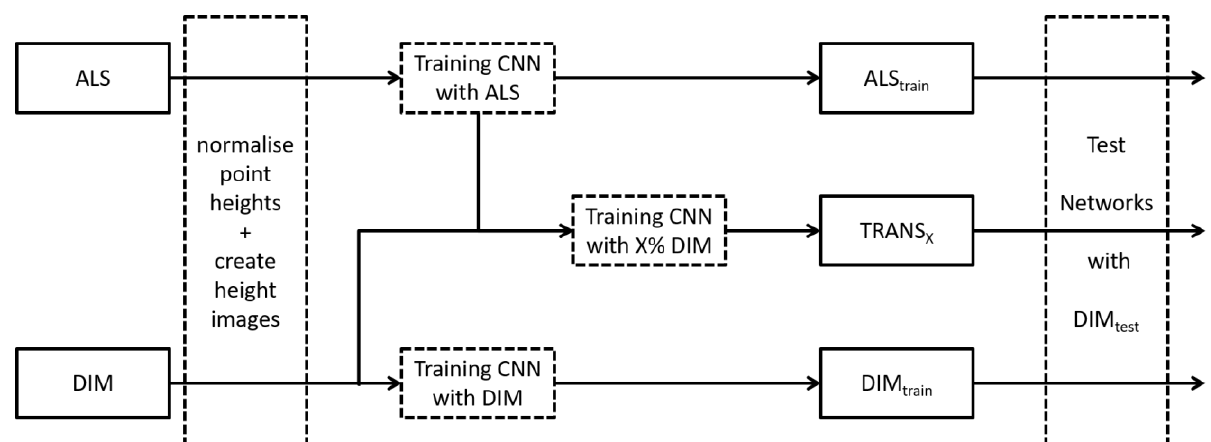
Figure 1: Workflow of our method. The heights of ALS and DIM point clouds are normalised and height images are created. ALS train , and DIM train are trained based exclusively on ALS or DIM point cloud as input data. TRANS x takes ALS train as baseline and fine- tunes the classification results using X% of DIM data. All setups are tested on a DIM test